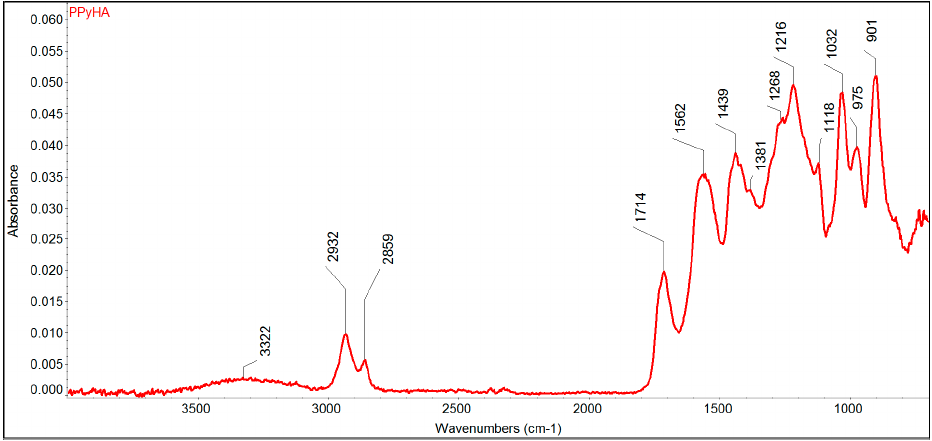
Figure 3. The X-ray photoelectron spectroscopy (XPS) spectrum of N 1 s core level (Mg K α radiation) of the PCL-PPyHA sample (red). Blue and green lines represent two binding modes of the nitrogen atom.